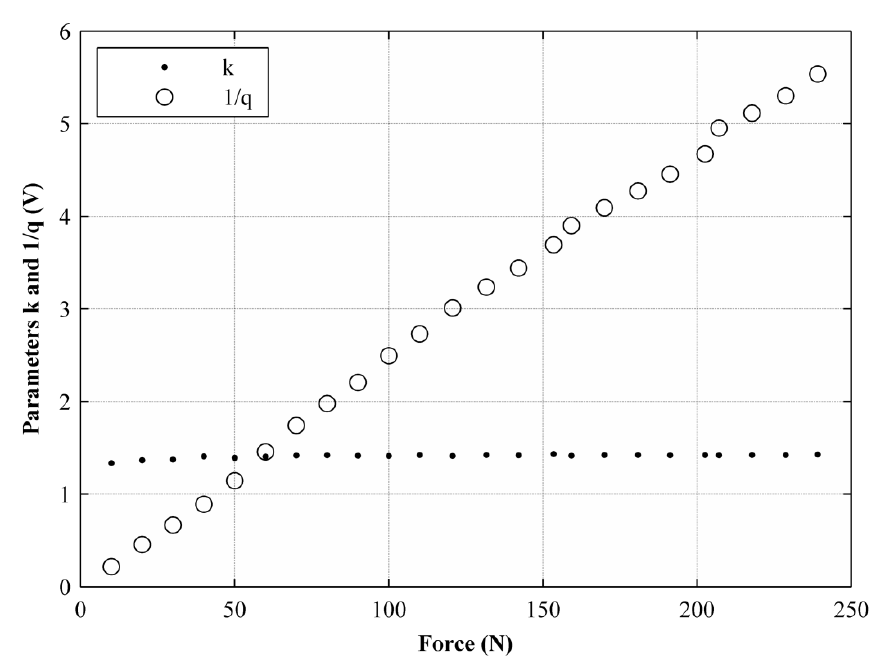
Figure 4. Graph representing the variation of sensor parameters k and q for different exerted forces within the range from 0 N to 250